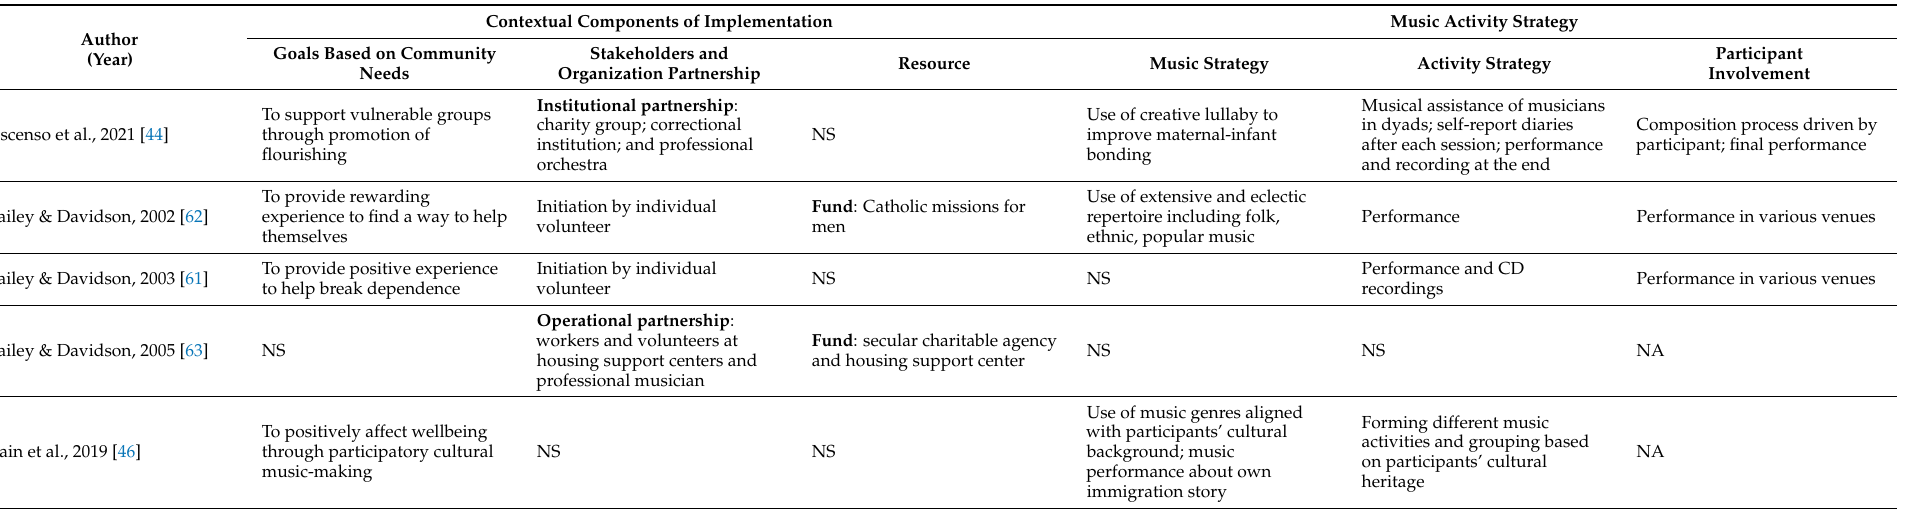
Table A2. Summary of implementation components and music activity